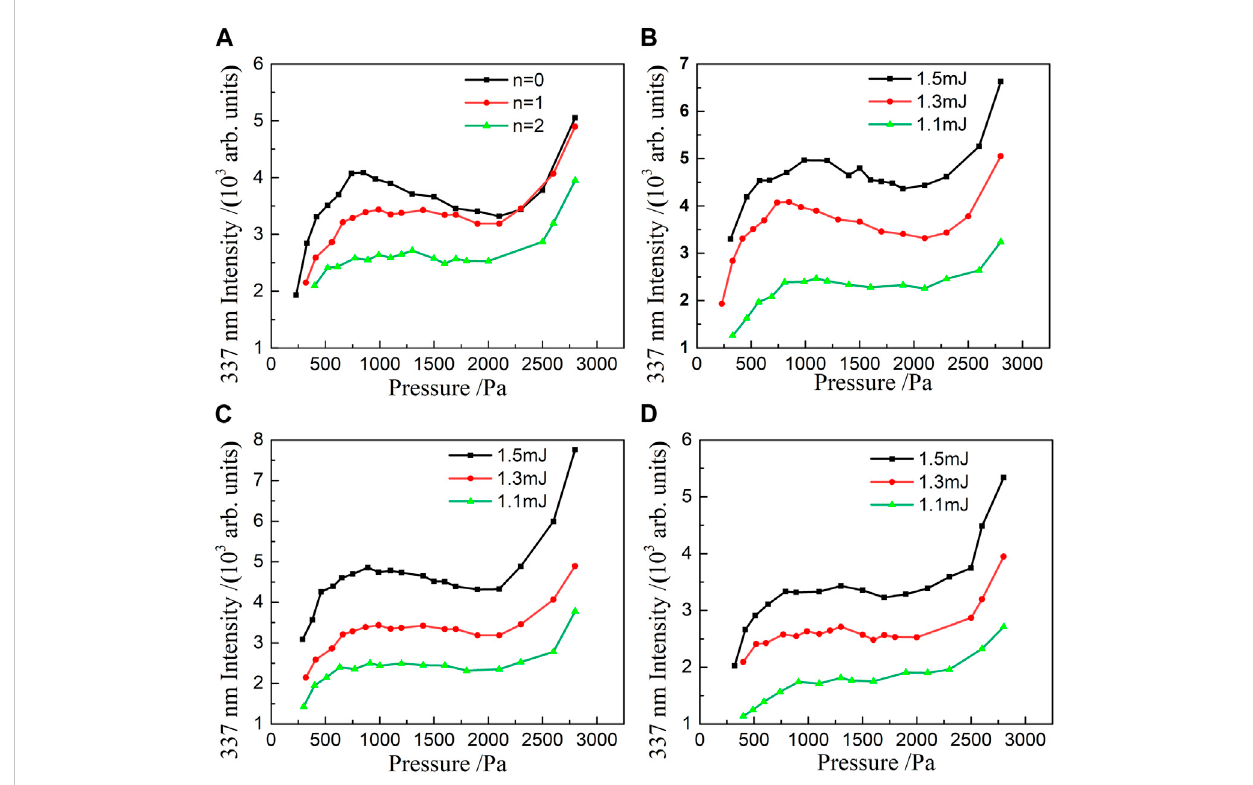
FIGURE 4 (A) Evolution of the fl uorescence emission at 337 nm with nitrogen gas pressure for different TCs when the pulse energy is 1.25 mJ. (B – D) 337-nm emission intensity versus the gas pressure for three different pulse energies with the TC of 0,1 and 2,